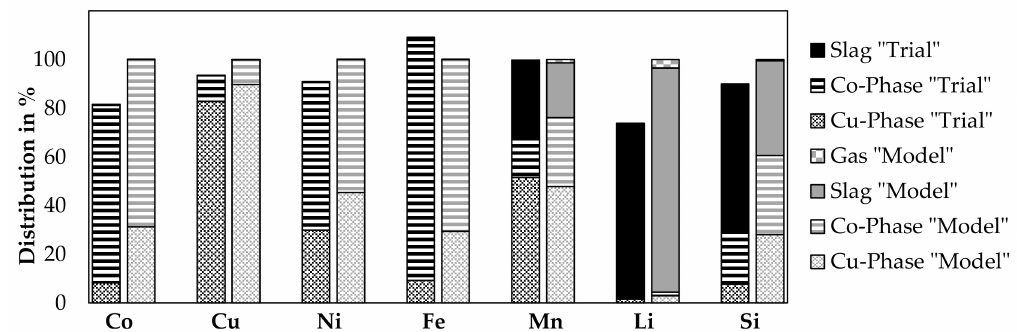
Figure 12. Distribution of elements in laboratory trials between, metal, slag and gas phase of Trial 3 and 4 ( left bars ) combined, compared with the thermochemical simulation ( right bars